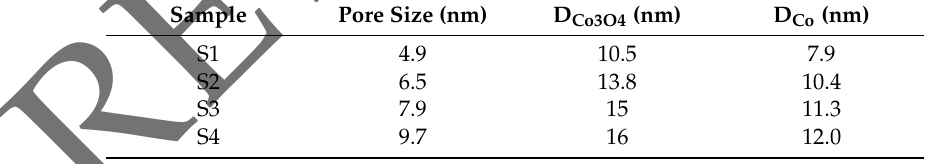
Figure 5. H 2 -TPR profiles of Co/SBA–15 samples with different pore sizes. Table 2. Average crystalline size of Co 3 O 4 estimated by the XRD method.